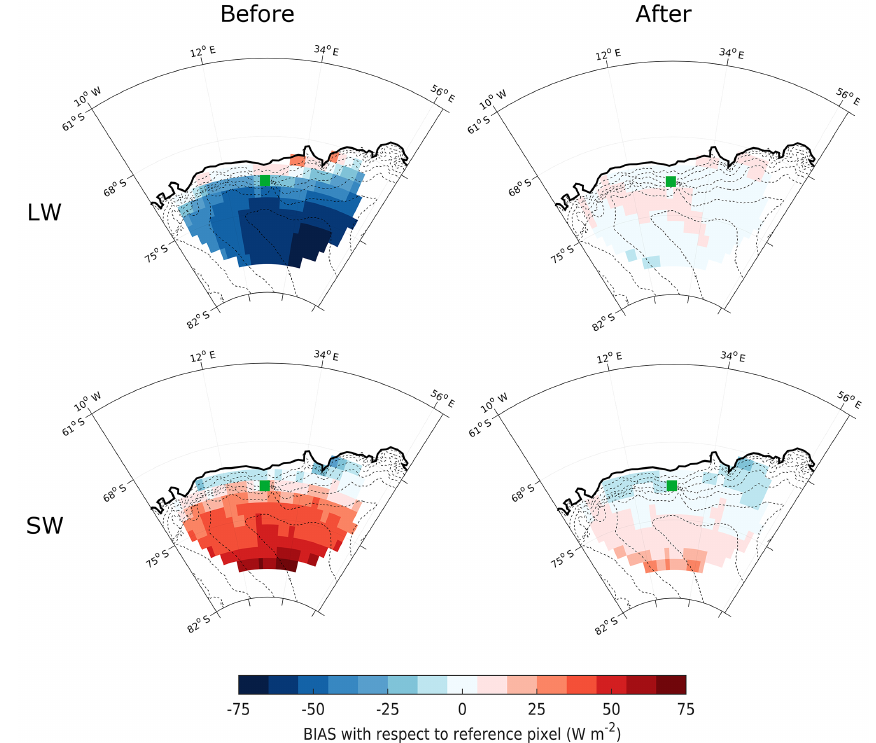
Figure 7. Yearly mean bias for each 2 ◦ by 1 ◦ grid box with respect to the centre pixel in which the AWS is located, before and after spatial correction for the example of PE, Antarctica (indicated by the green square). These results are based on all 2B-FLXHR-LIDAR data from 2007 to 2010 within a distance of 1000km from the station. It should be noted that the comparison before spatial correction here has also been masked for ocean and different surface albedos.